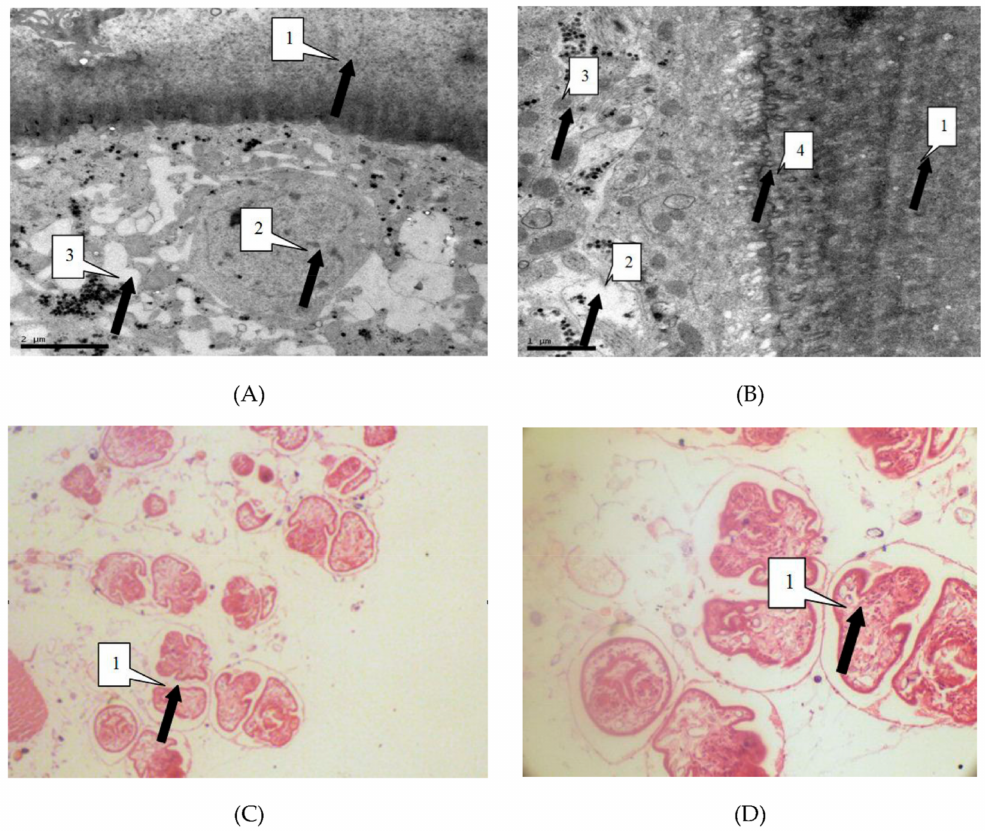
Figure 4. ( A ) Electron microscope magnified 12,000 times. As shown by the arrow, the villi that the germinal layer (1) extended to the laminated layer (2) has disappeared (100/100). Organelle such as cells of the germinal layer (1) mitochondria and Golgi complex lost basic integrity. There was a large number of vacuoles (3) in the cells of the germinal layer (100/100). ( B ) described equally to the Figure A. Electron microscope magnified 25,000 times. ( C ) The light microscope magnified 400 times. As shown by the arrow, the protoscolexs were valgus (1). ( D ) The light microscope magnified 1000 times. The Figure D described equally to the Figure